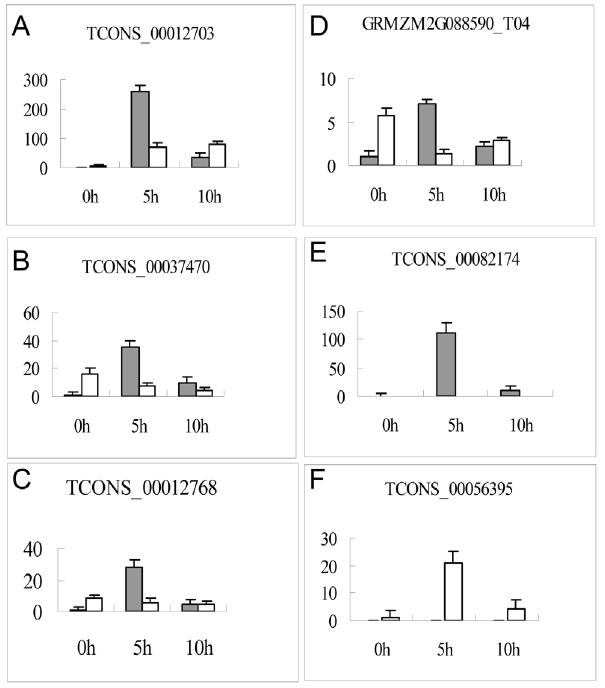
Figure 4. Quantitative analysis of 6 siRNA precursor lncRNAs in the leaves and roots using RT-qPCR at 0, 5 and 10 h. The gray bar denotes leaf samples and the white bar denotes root samples. GAPDH RNA was used as the internal control. Error bars indicate SD obtained from three biological repeats.